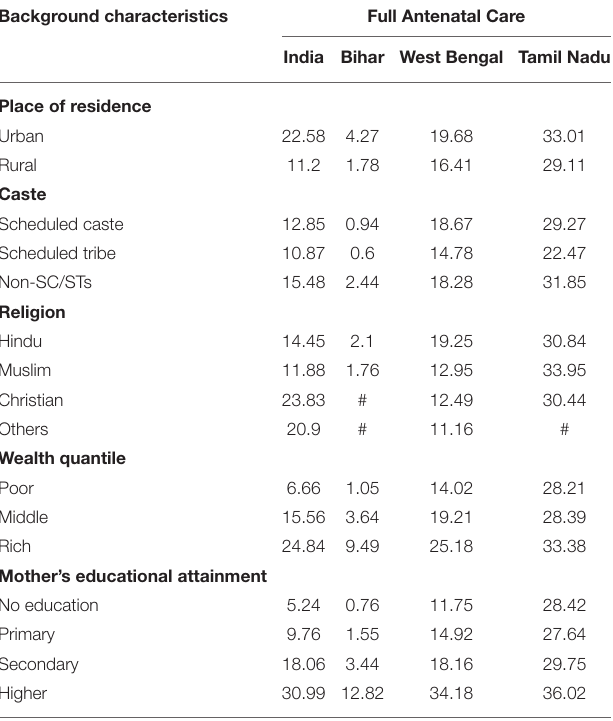
Background characteristics Full Antenatal Care